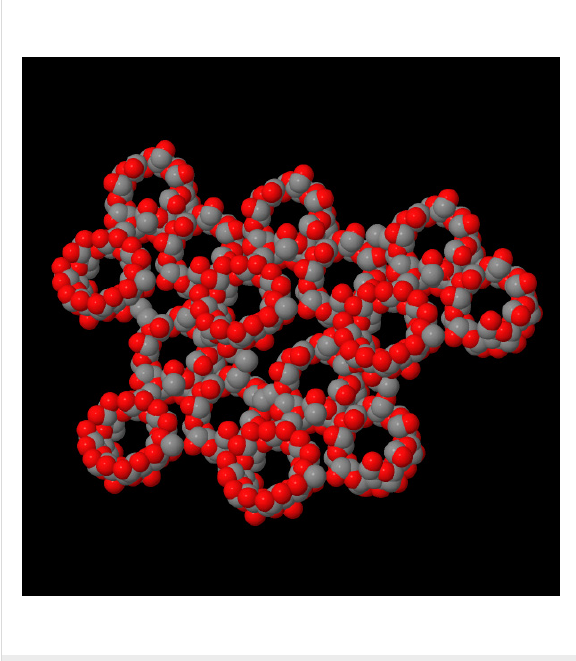
Figure 1: Molecular structure of cyclodextrin carbonate nanosponges.